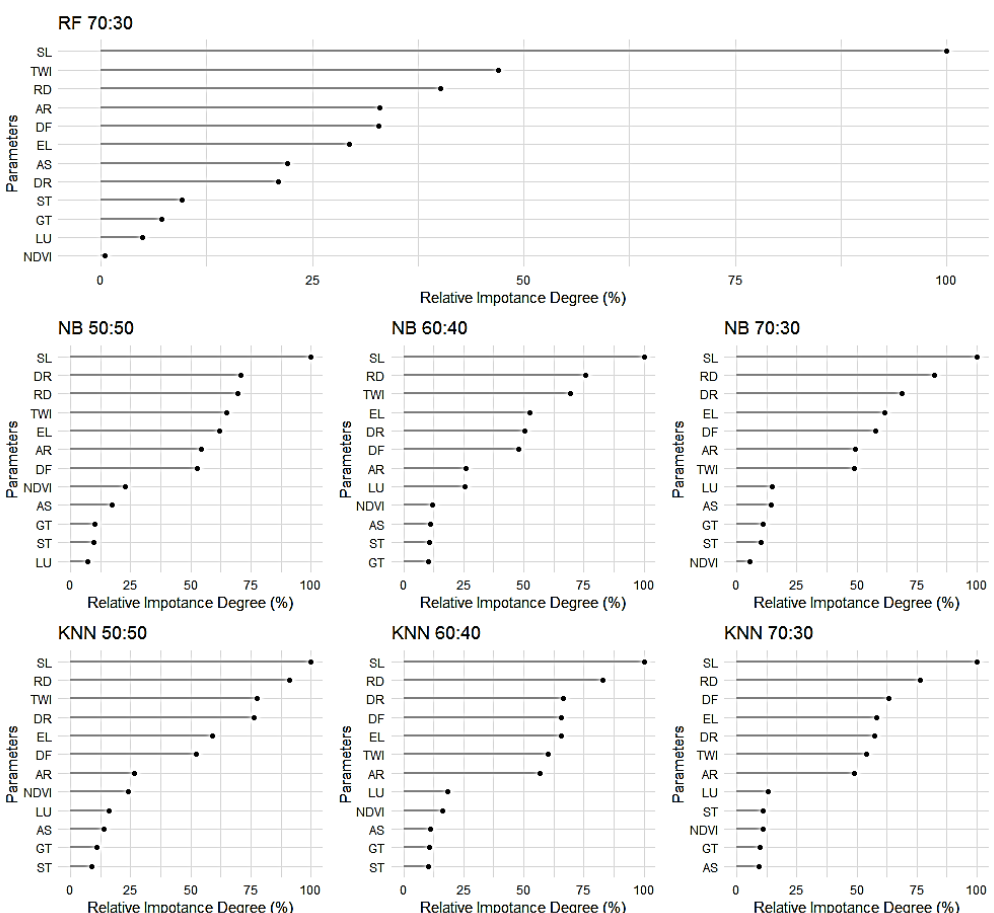
Figure 11. Relative contribution degree of each model (SL = slope; RD = river density; DR = distance to river; EL = elevation; AR = annual rainfall; DF = distance to fault; AS = aspect; GT = geological type; ST = soil type; LU = land use).